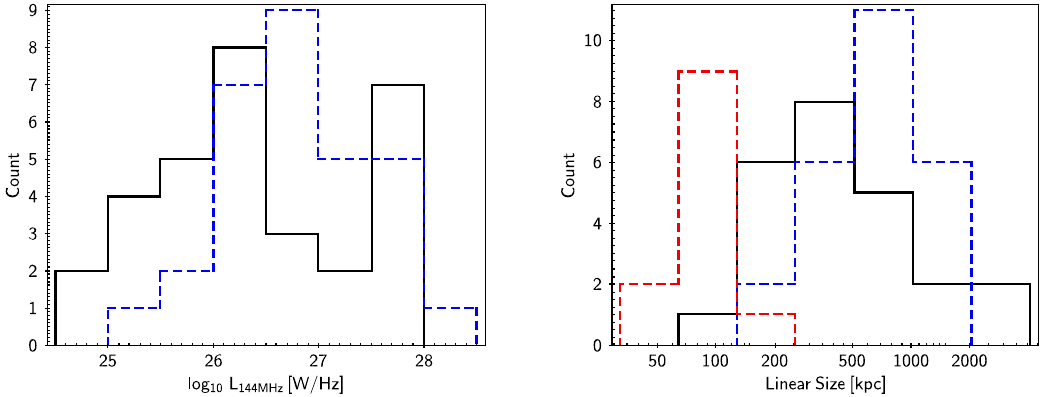
Figure 2. ( Left panel ) histograms of radio luminosity at 144 MHz ( L 144MHz ) for the polarised sources with spectroscopic (solid line) and photometric (dashed blue line) redshifts. Radio luminosities are consistent with all sources being radio-loud AGN; ( right panel ) histograms of the projected linear size of resolved sources with spectroscopic (solid line) and photometric (blue dashed line) redshifts. The red dashed line shows the histogram of upper limits on the projected linear size of unresolved sources with redshift